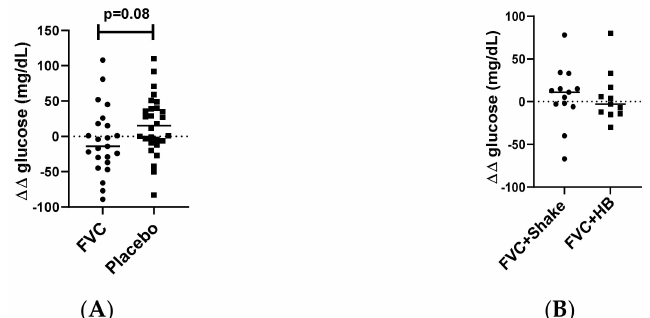
Figure 1. Oral glucose tolerance test. Blood glucose levels were measured after an overnight fast (x) and again 90 min after consuming a beverage containing 75 g of dextrose (y) to determine glucose clearance ( ∆ = y − x). The test was repeated at baseline and months 4 and 5. The difference in clearance ( ∆∆ ) between ( A ) baseline and month 4 for FVC vs. Placebo (N = 27, FVC; N = 30, placebo) and ( B ) month 4 and 5 for Shake vs. HB ( n = 14, FVC + Shake; n = 12; FVC + HB) was calculated. Significance between groups were determined using non-parametric Wilcoxon test. FVC, dried fruit and vegetable supplement; HB, habitual